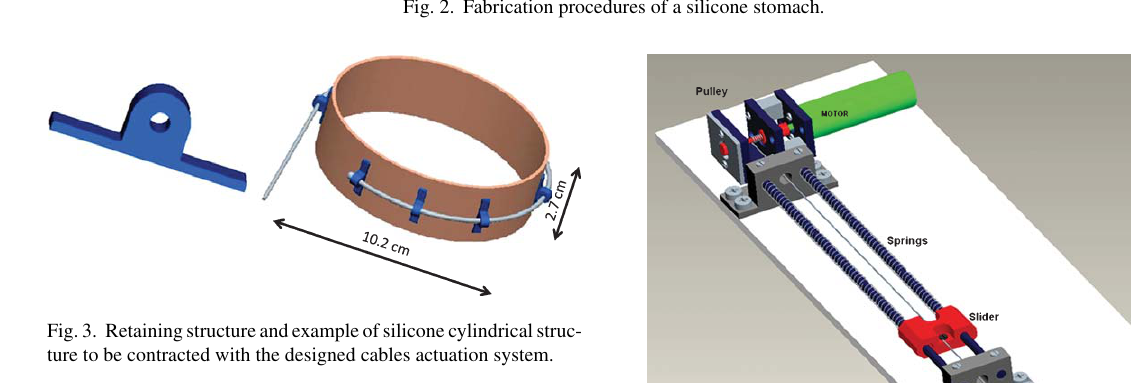
three regions depending on the level of ACW occlu- sion. In the proximal region ranging from 140 to 100 mm of distance to the pylorus, the relative occlu- sion of ACW ( (cid:1) ) decreases linearly from 1 to 0.6.